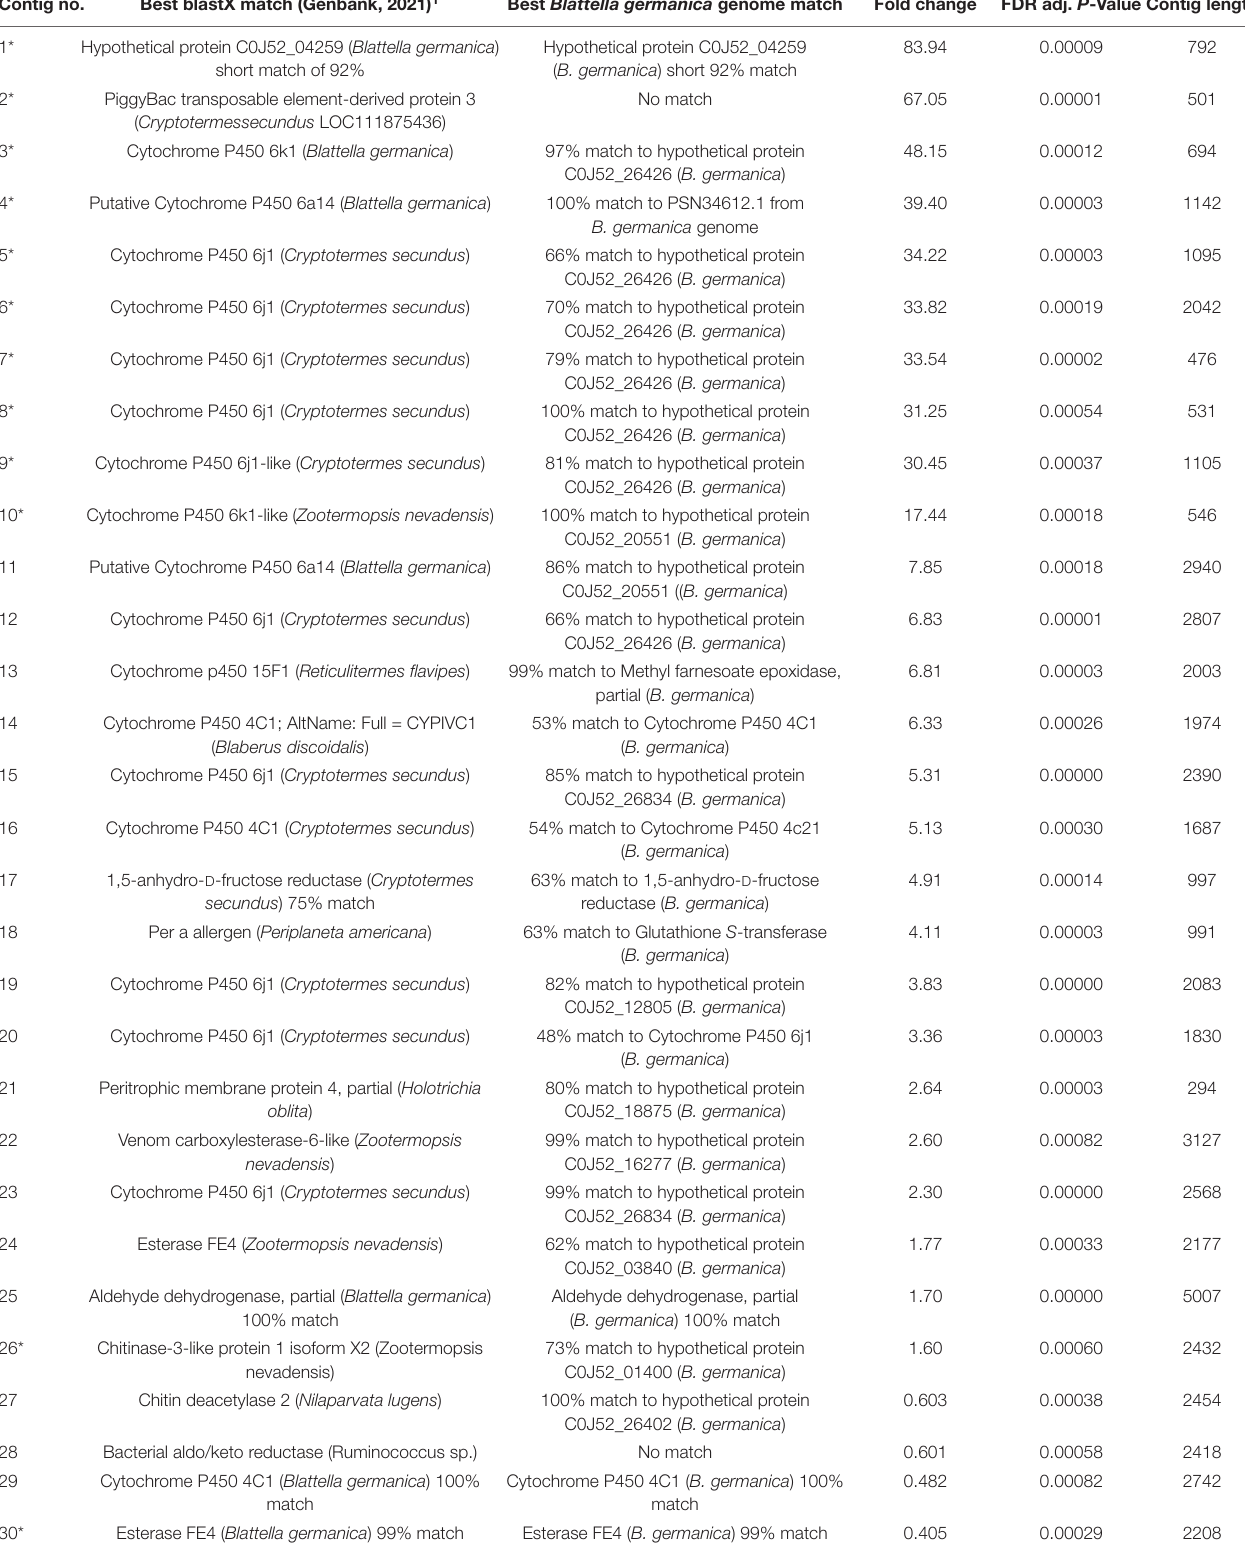
TABLE 1 | An overview of 53 transcript contigs that were significantly differentially expressed with selection for indoxacarb resistance. Contig